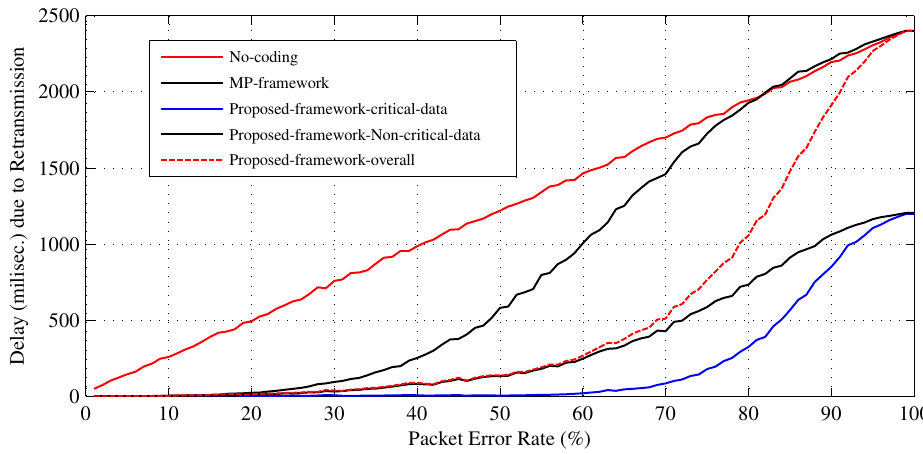
Figure 13. Data delivery delay due to the